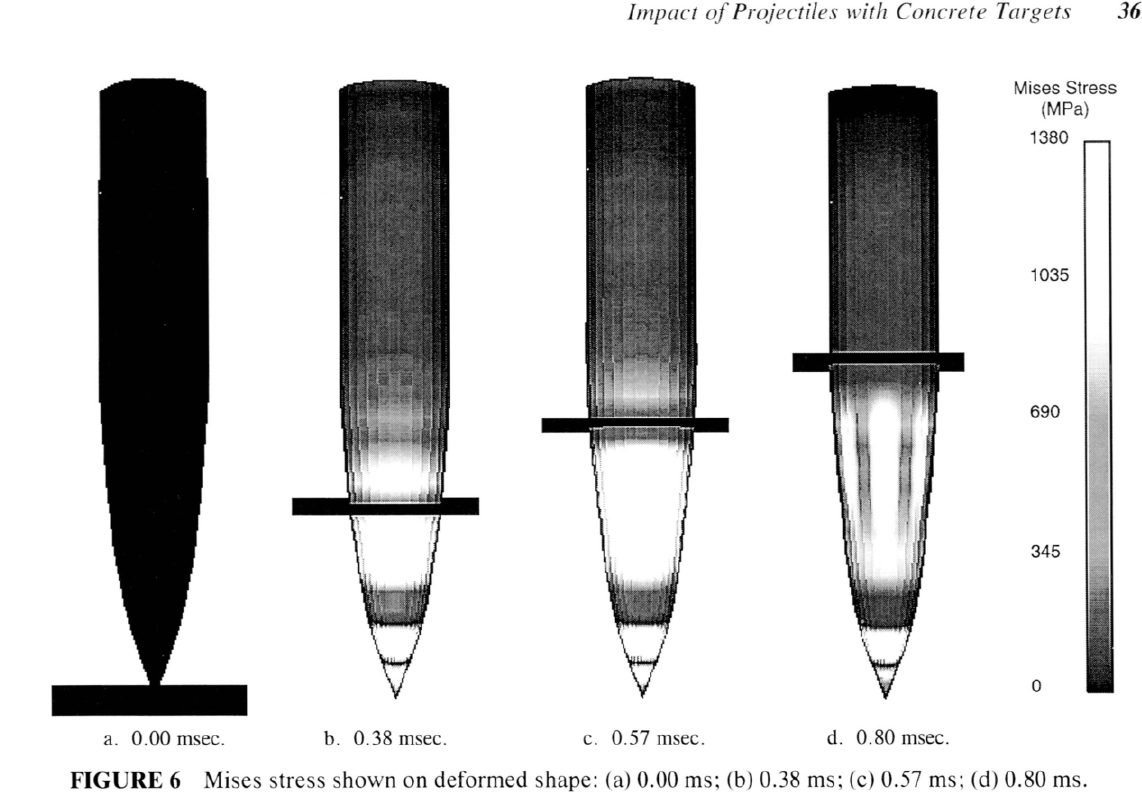
FIGURE 6 Mises stress shown on deformed shape: (a) 0.00 ms; (b) 0.38 ms; (c) 0.S7 ms; (d) 0.80